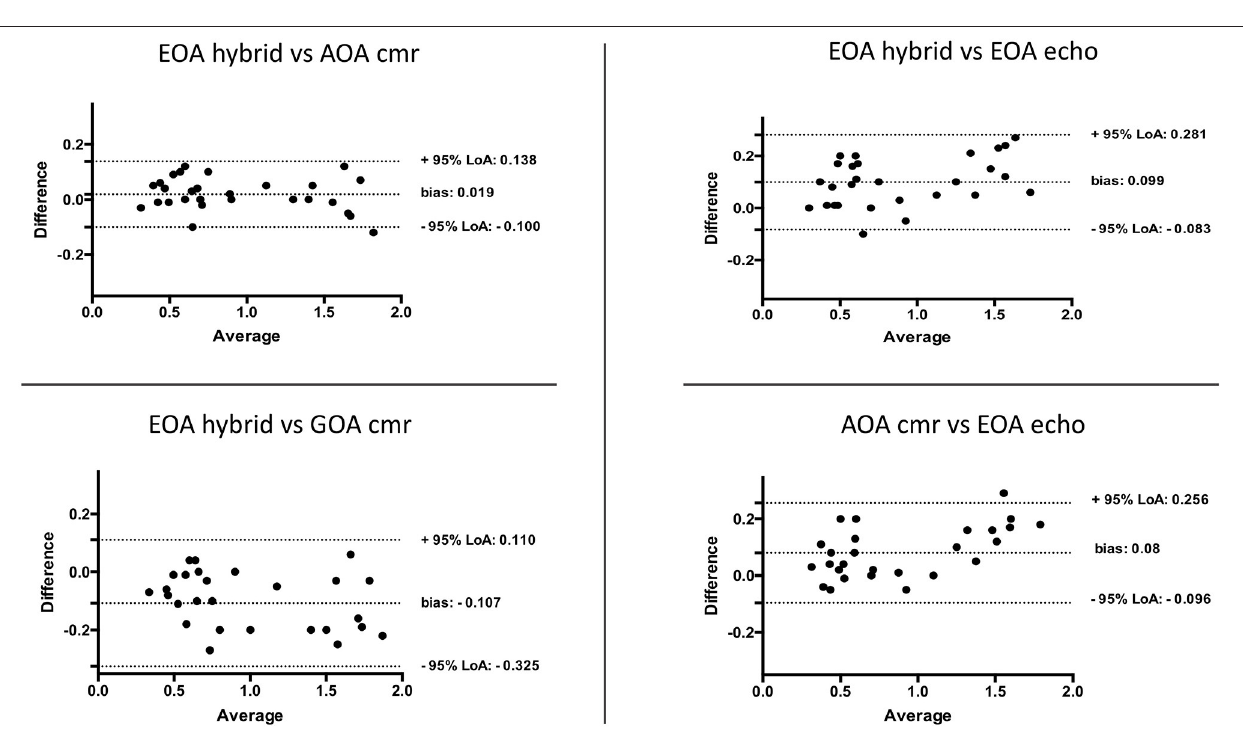
moving from severe to moderate AS. EOA echo and GOA cmr reclassified, respectively, 6/28 (21%) and 9/28 (32%) subjects. When using EOA echo as the reference, AOA cmr underestimated AS severity in three patients